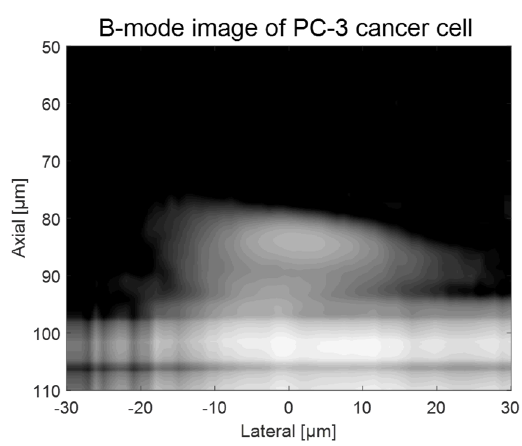
Figure 6. B-mode imaging of a PC-3 cell with a 110 MHz transducer.